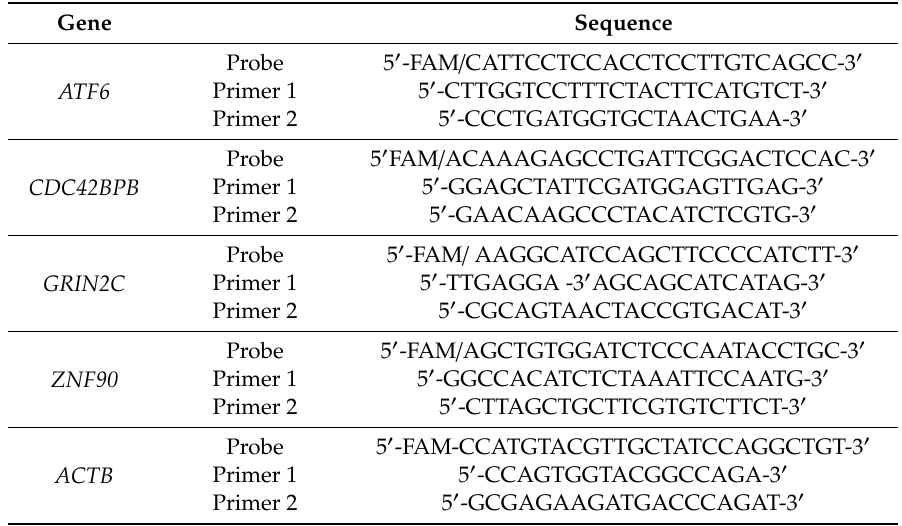
Table 4. qPCR primer / probe sequence.